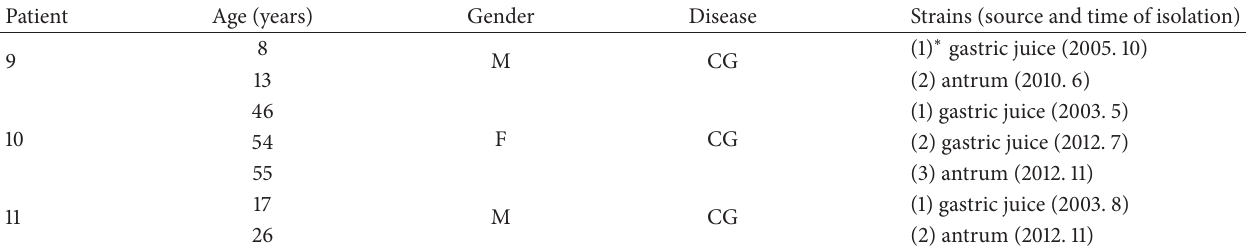
Table 2: Characteristics of patients from whom plural isolates, which were thought to be originated from the same clone, were obtained from specimens obtained with long